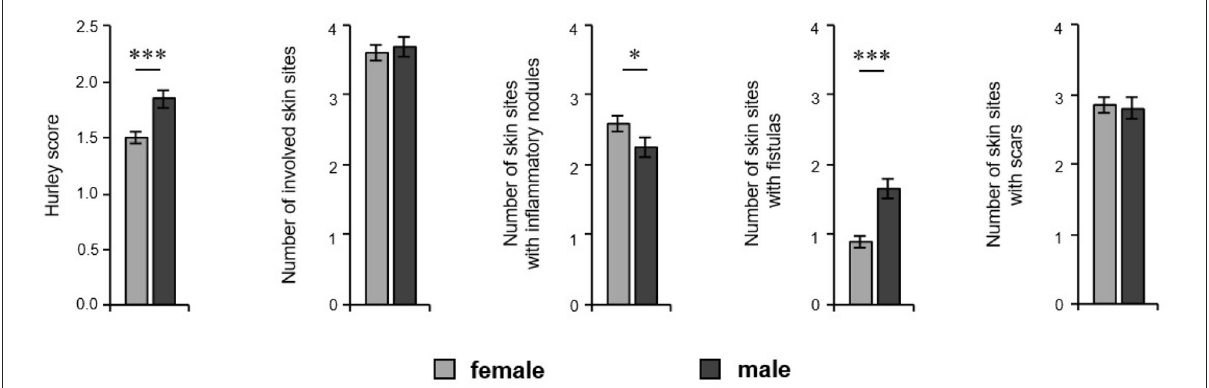
FIGURE3 Extent of HS cutaneous alterations in both sexes. The disease severity (Hurley score, n = 424, female: 259, male: 163), the number of involved skin sites considering right and left axillary, right and left inguinal, and right and left gluteal sites as well as the pilonidal sinus, and the number of those skin regions with inflammatory nodules, fistulas, and scars of HS patients ( n = 429, female: 262, male: 169) are demonstrated as the mean ± SEM. Significance of differences was assessed by the Mann–Whitney U-test (two-tailed; * P < 0.05, *** P ≤ 0.001).